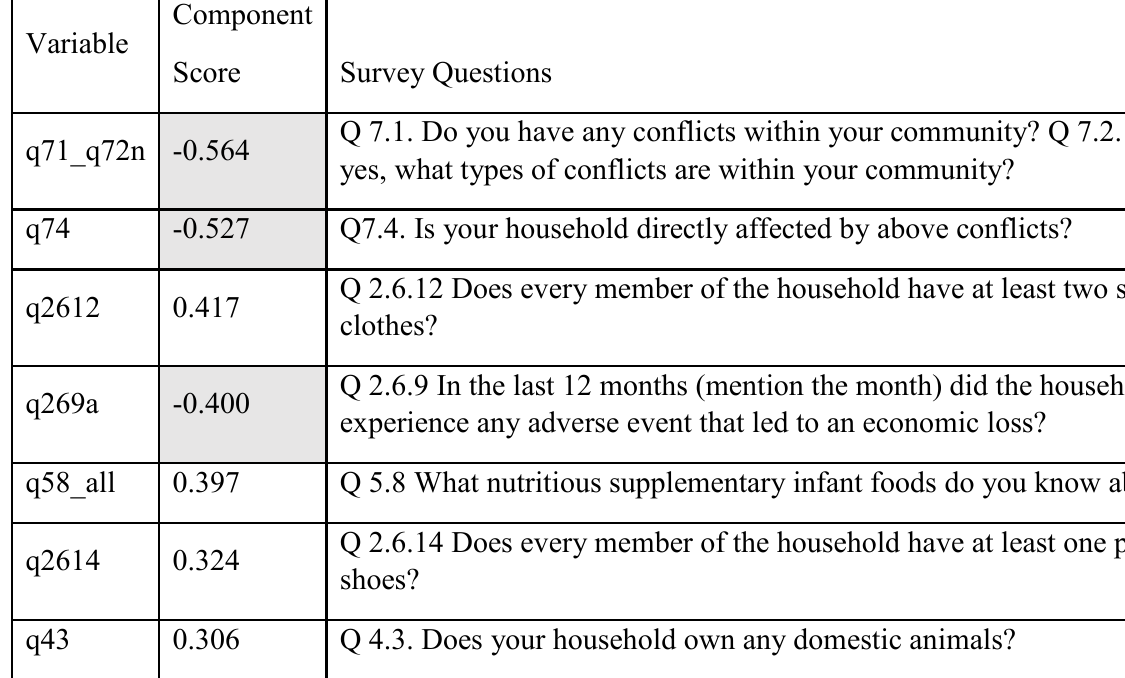
Table 1.8: Variables defining Absorptive Resilience